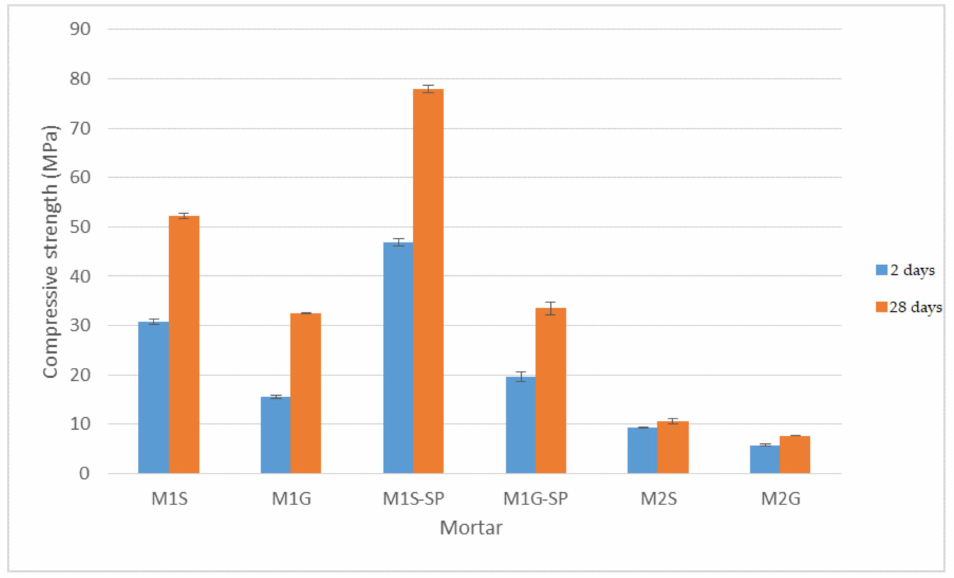
Figure 2. 2-day and 28 days mortar compressive